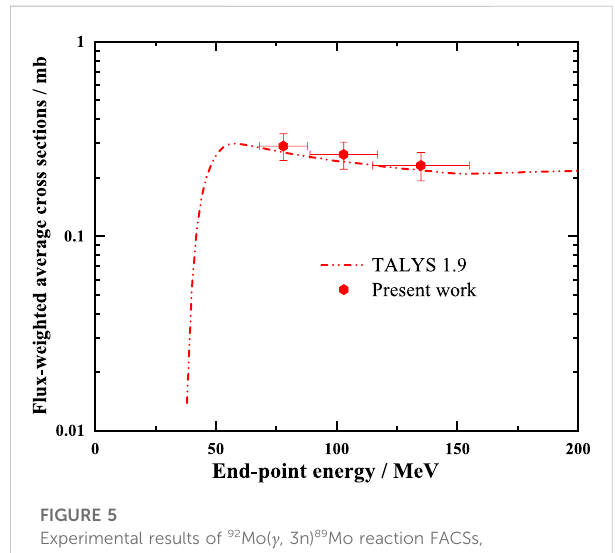
FIGURE 5 Experimental results of 92 Mo( γ , 3n) 89 Mo reaction FACSs, comparing with TALYS 1.9